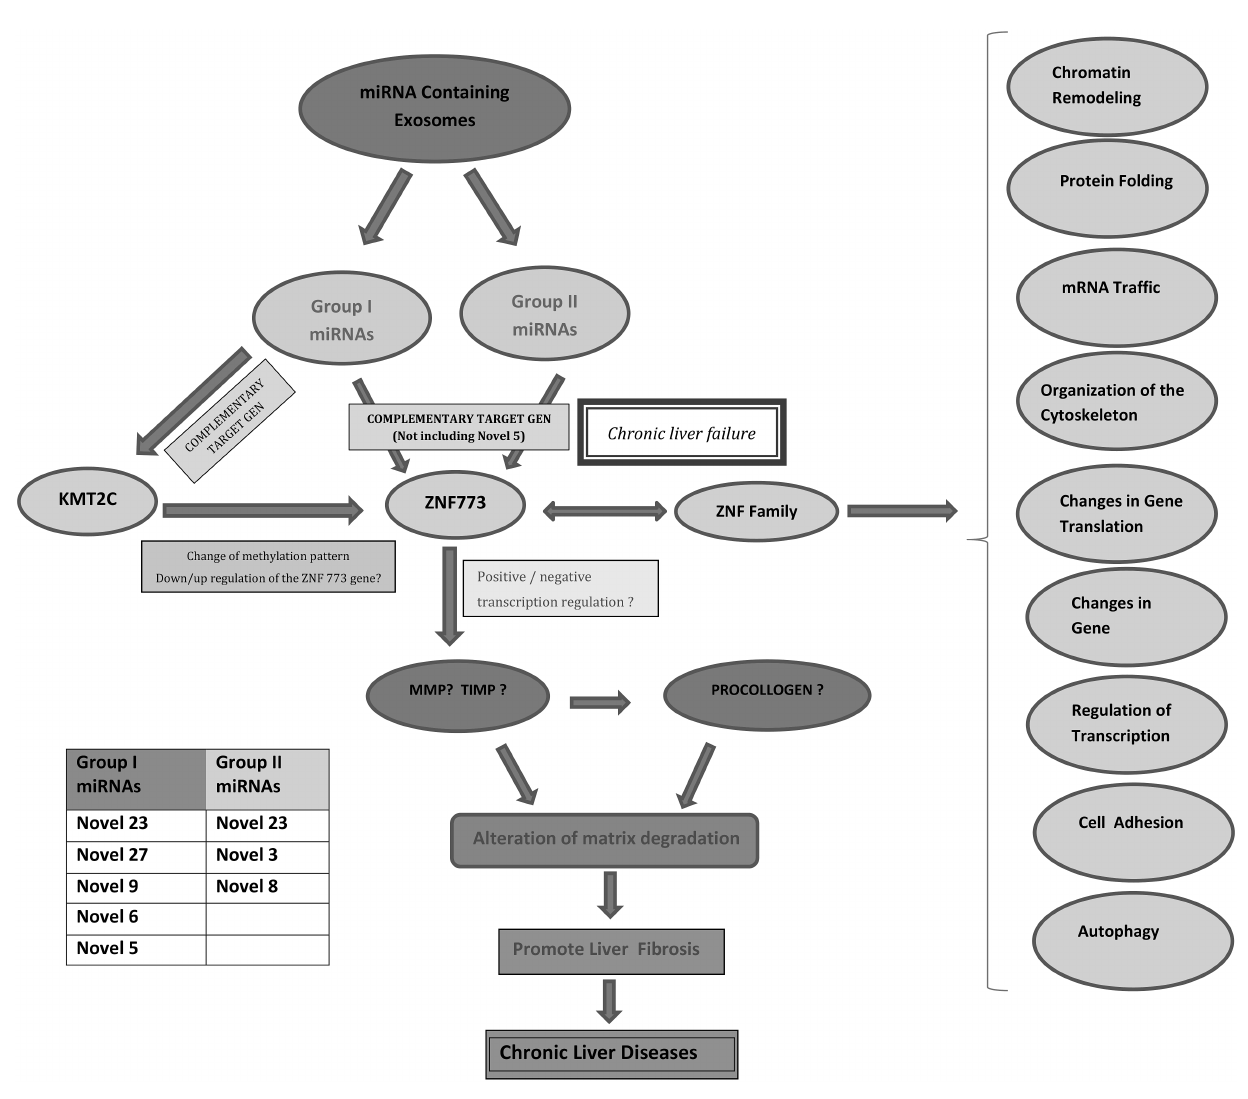
Figure 5. How miRNAs carried by EPDENs in coffee can affect liver fibrosis in chronic liver diseases via ZNF773 and KMT2C genes is schematized using a hypothetical mechanism. KMT2C, lysine methyltransferase 2C; MMP, matrix metalloproteinase; TIMP, tissue inhibitor of metalloproteinase; ZNF, zinc